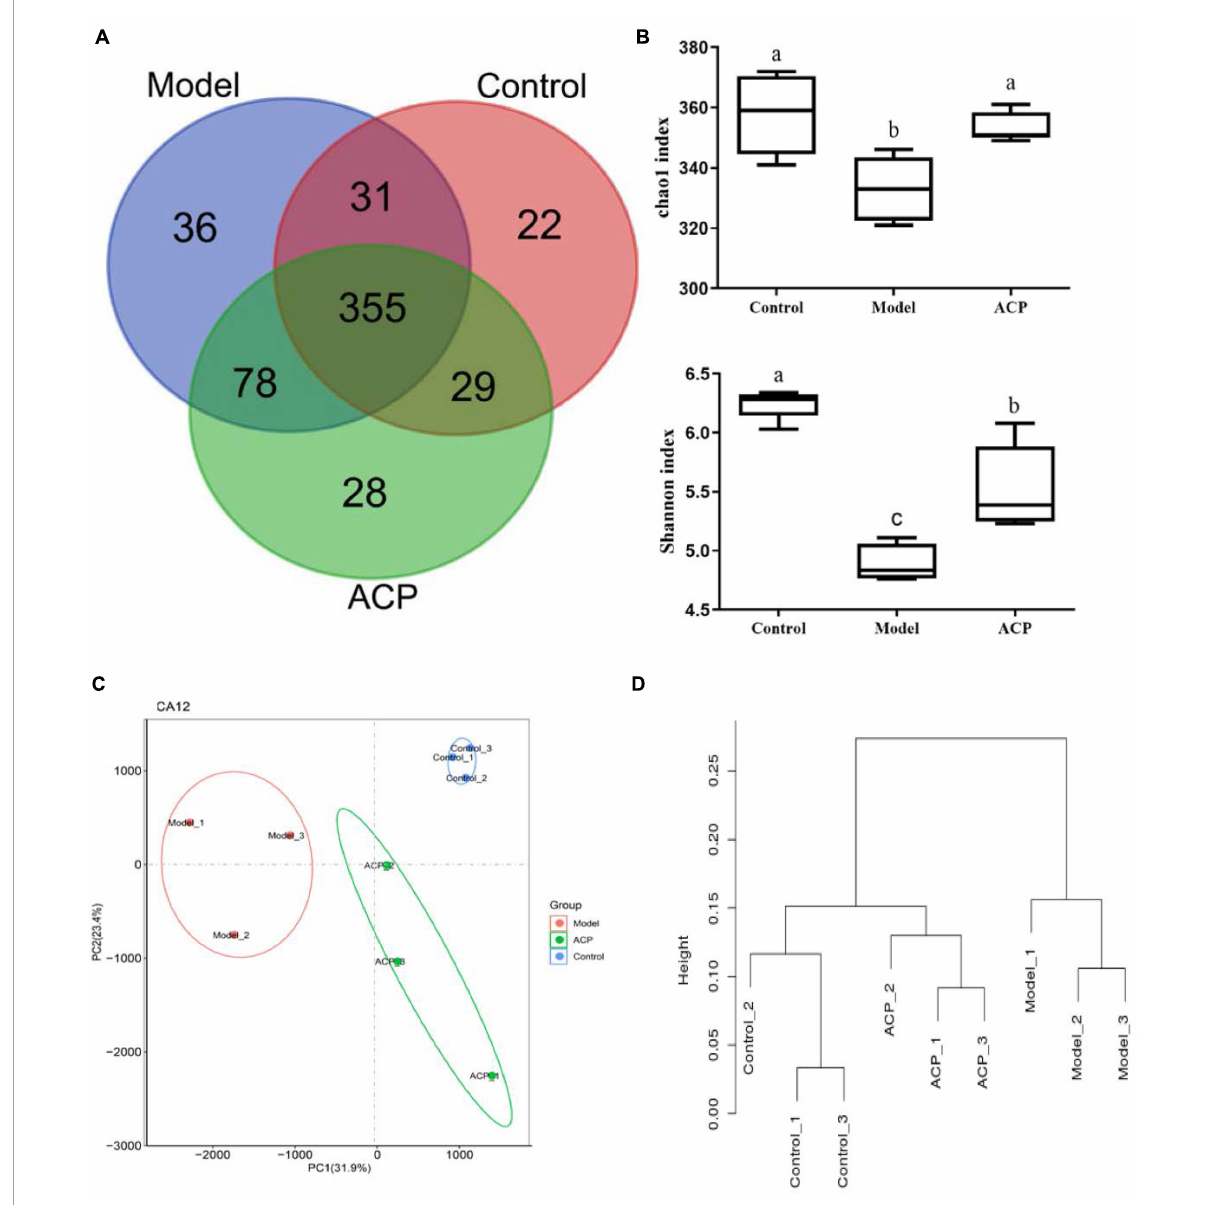
FIGURE4 Effect of Auricularia cornea var. Li. polysaccharides (ACP) supplementation on the diversity indexes of gut microbiota in immunosuppressed mice. (A) Common and unique operational taxonomic units (OTUs) analysis results, (B) α -diversity analysis (chao1 index and Shannon index), (C) PCA analysis based on OTUs and (D) weighted UniFrac distance tree. Values are mean ± SD ( n = 6 independent experiment). Different superscript letters indicate significant differences ( P < 0.05) by using one-way analysis of variance, followed by Duncan’s